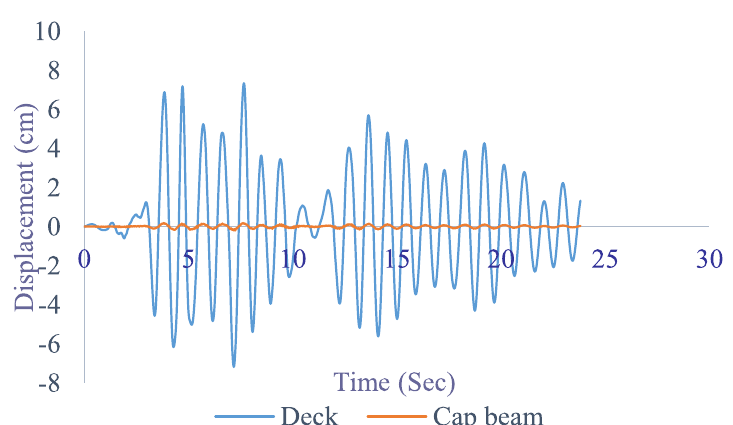
Fig. 16 The lateral displacement of points Deck and Cap beam in the transverse direction (Y) in model 2 under Tabas earthquake